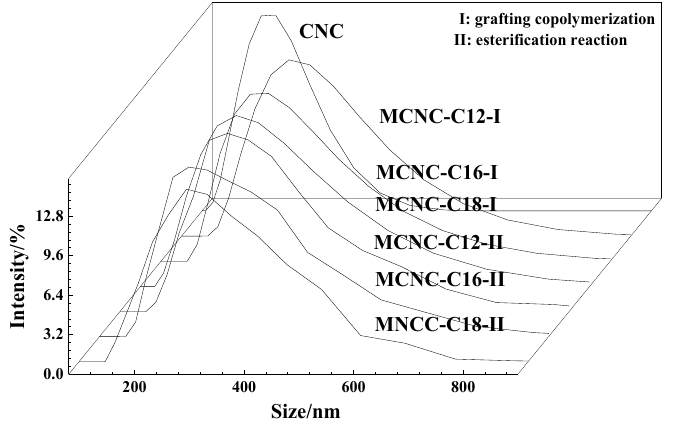
Figure 6. Particle size distribution of MCNC.